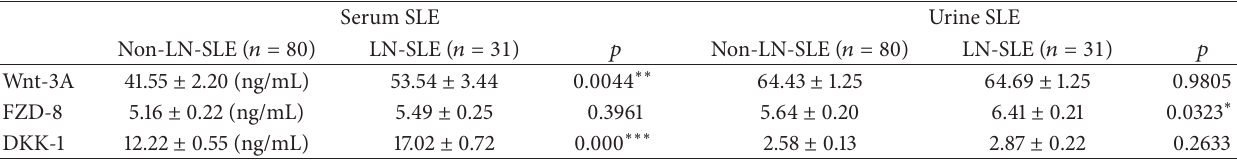
Table 3: The abundances of Wnt-3A, FZD-8, and DKK-1 proteins in the sera and urine of patients with SLE. Serum SLE Urine SLE Non-LN-SLE ( 𝑛 = 80 )